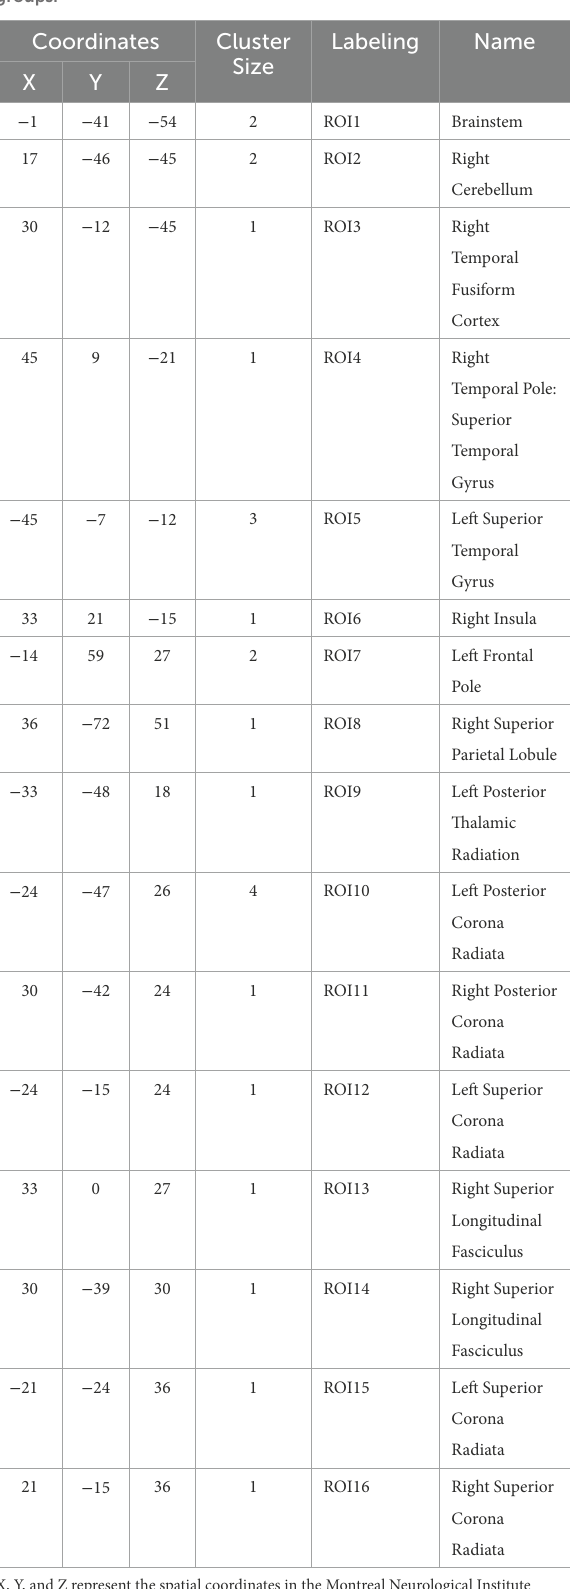
TABLE 3 ROI with significant differences in the PD and control